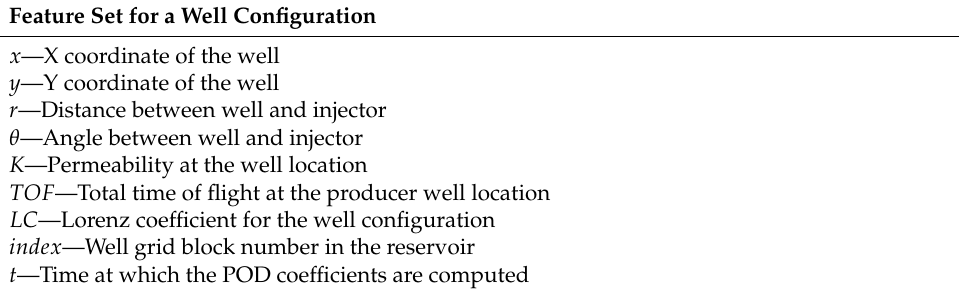
Table 1. Geometric and physics-based features for ML model construction corresponding to the well